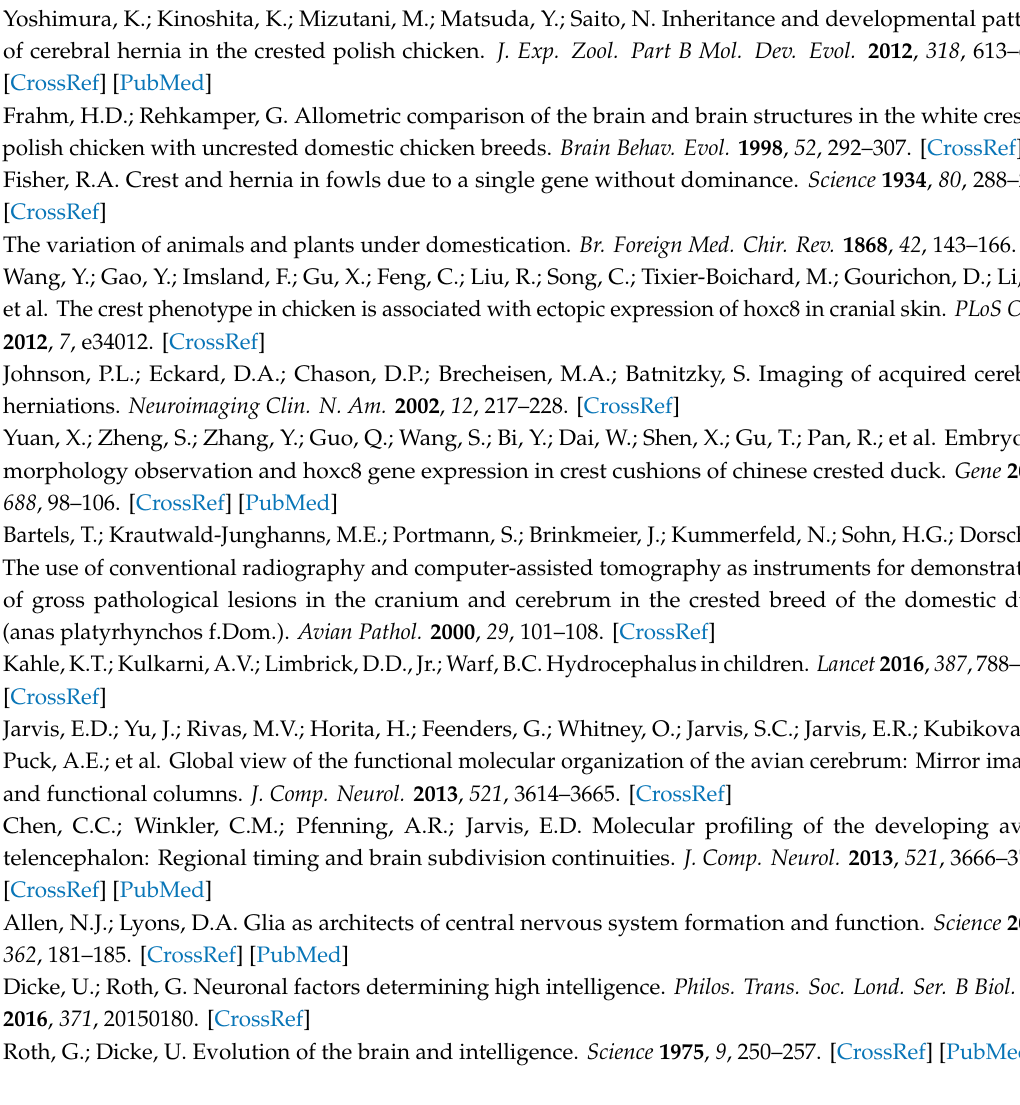
Figure S1. Morphological characterization after removal of the membranous frontal skull in chickens with and without cerebral hernia; Figure S2. Enrichment of GO terms for downregulated and upregulated genes; Figure S3. Methylation levels of GFAP in the exon1 region are decreased in telencephalon of chickens with cerebral hernia; Table S1. Primers used for the touchdown PCR; Table S2. Di ff erentially expressed transcripts in the telencephalon between wild type and cerebral hernia type chickens; Table S3. Primers used for qRT-PCR; Table S4. Statistics of Raw reads and clean reads in the telencephalon of wild type and cerebral hernia type